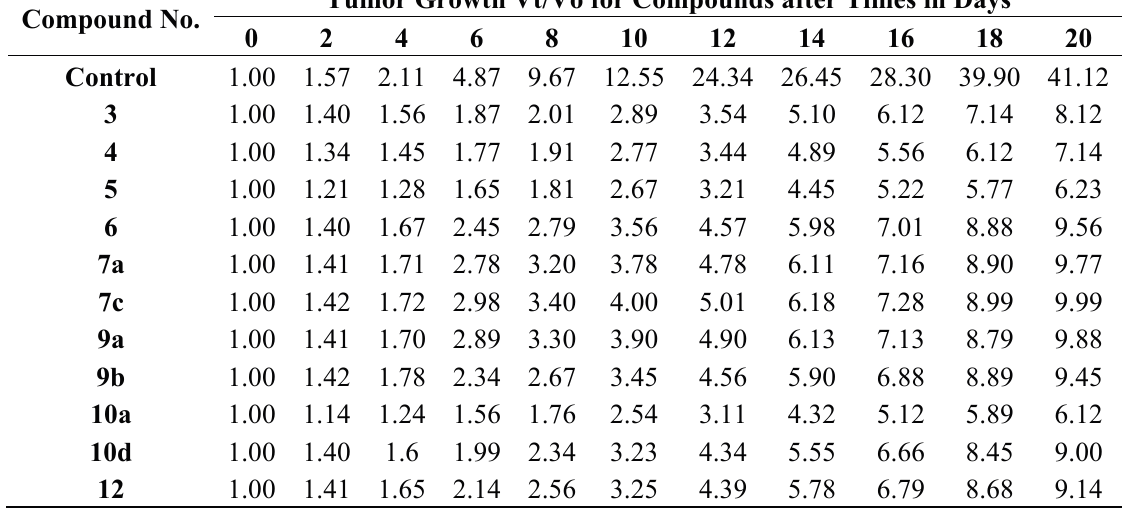
Table 4. In vivo anti-tumor activity of the tested compounds was evaluated in an MCF-7 mouse xenograft model of breast cancer. Compound